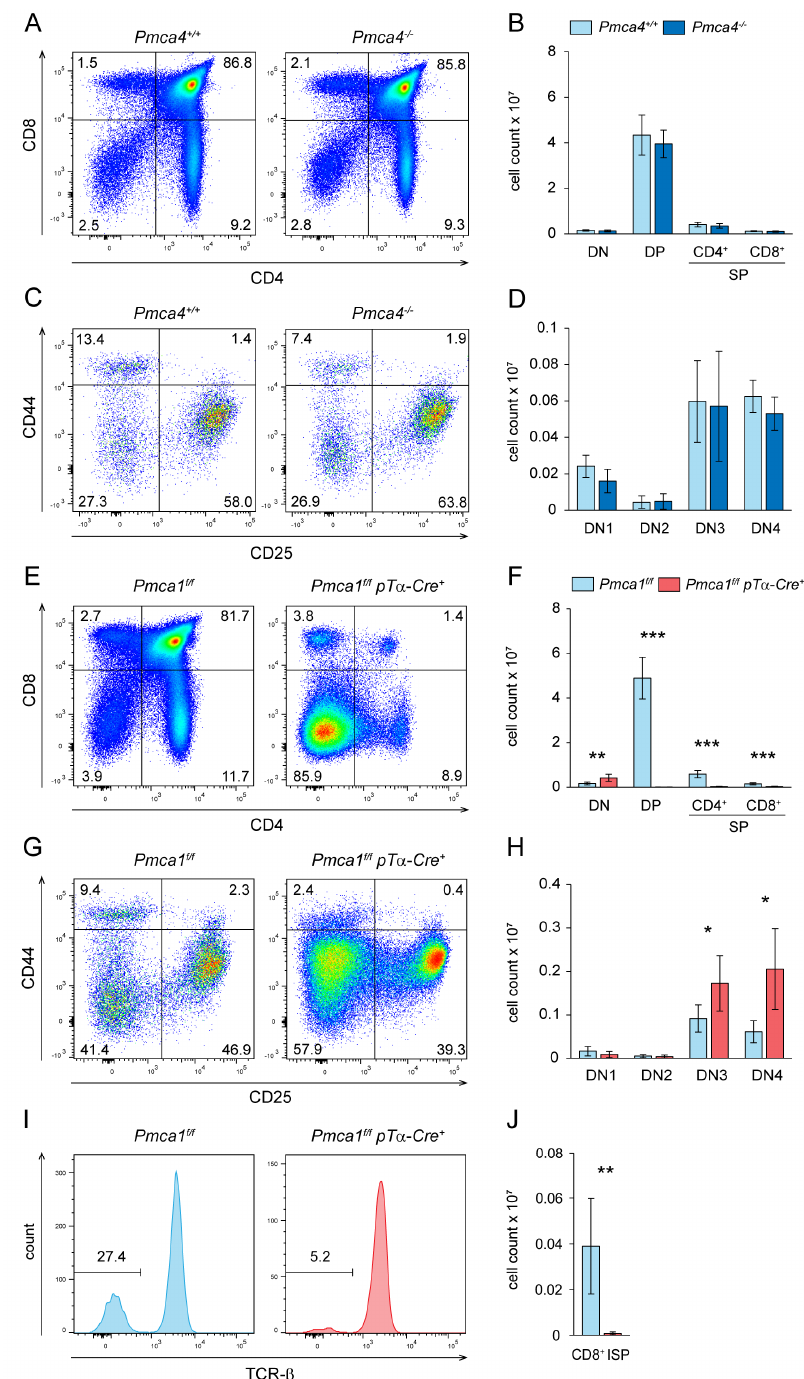
Figure 2. T cell development is normal in mice with PMCA4 deficiency but almost completely blocked in mice with a conditional deletion of the Pmca1 gene. Thymocytes of Pmca4 +/+ control and Pmca4 − / − mice ( A – D ) or Pmca1 f/f pT α -Cre − control and Pmca1 f/f pT α -Cre + mice ( E – J ), respectively, were